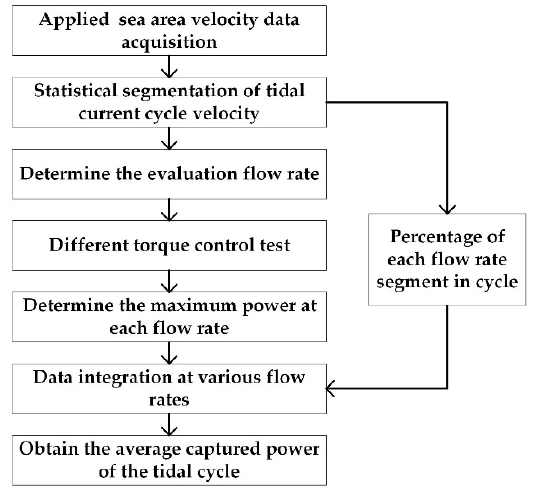
Figure 1. Turbine performance evaluation flowchart.